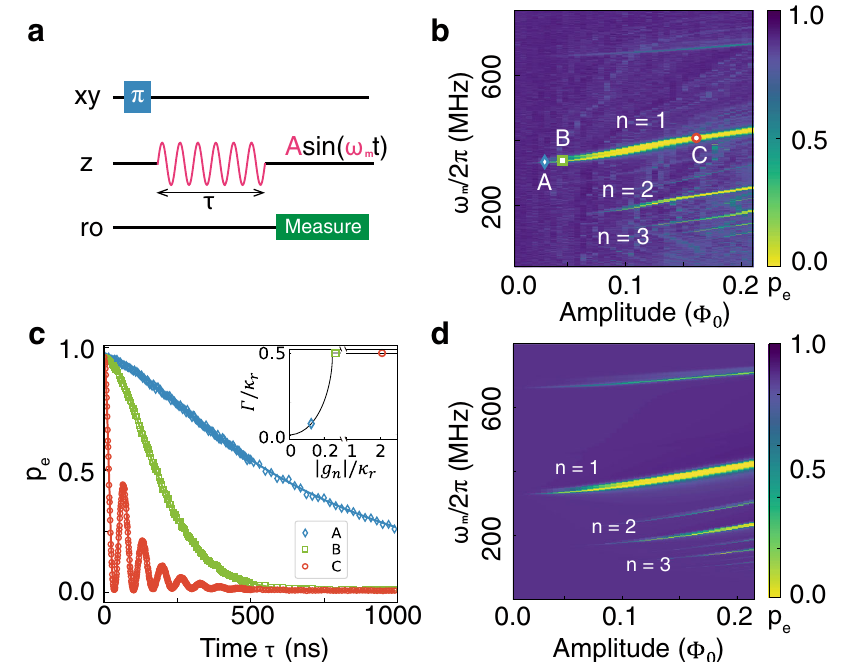
Fig. 2 Realization of the parametric reset on Q1. a Experimental sequence of the parametric reset. A π -pulse is applied to the qubit and followed by a sinusoidal parametric reset pulse. The amplitude A and angular frequency ω m are two adjustable parameters. b Two dimensional scan of the e j i population, p e when ω q /2 π = 5.784 GHz, ω r /2 π = 6.441 GHz, Δ /2 π = − 0.659 GHz. The x-axis is the parametric amplitude in the magnetic fl ux quantum Φ 0 and the y-axis is the modulation frequency. First, second, and third-order modulations are labeled n = 1, 2, 3, respectively. c Time evolution of the excited state population, after parametric modulation corresponding to the three points A, B, C in the n = 1 region in b . Dots are the raw data acquired by direct readout measurements, and solid lines are fi ts to the theoretical model. The insert shows theoretical values of Γ / κ r vs. ∣ g n ∣ / κ , where Γ is the reset rate of the qubit during the reset process. d Master equation simulation of the whole process with the same parameters as the experimental ( b ).